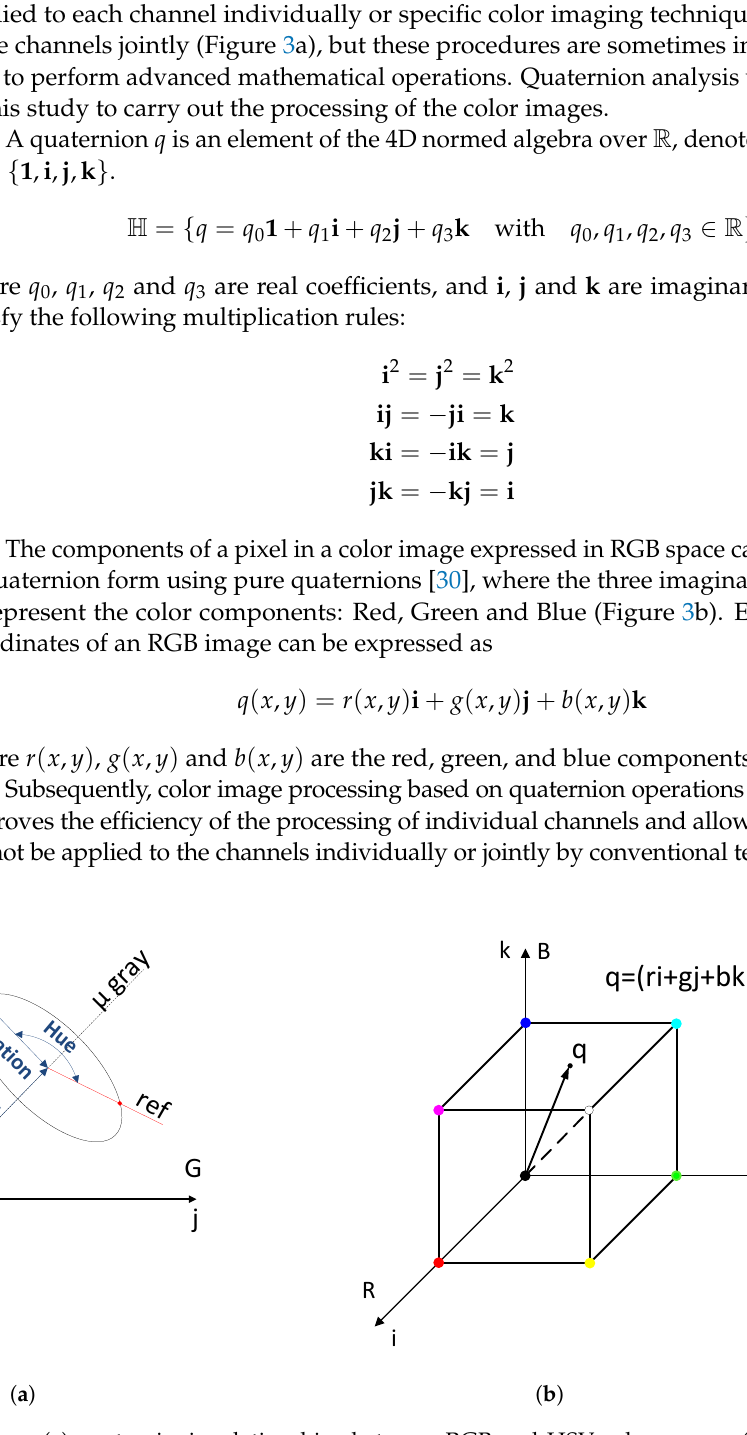
Figure 3. Color image processing: ( a ) quaternionic relationships between RGB and HSV color spaces, ( b ) geometric representation of a color by